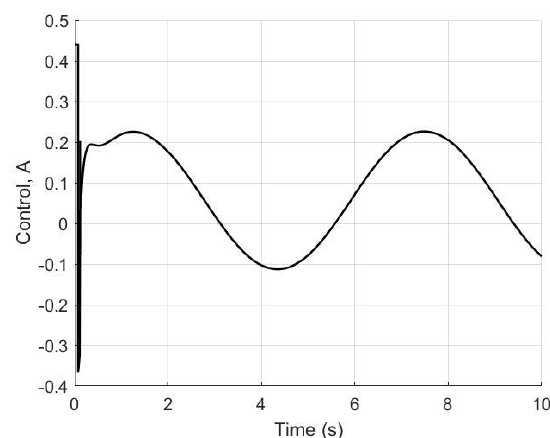
Figure 8. Experiment 2. In ( a ), plots of the mixed variable e 5 ( t ) = f 41 ( t ) and its estimate v 4 ( t ) ; in ( b ), plot of the estimation error f 41 ( t ) − v 4 ( t ) .